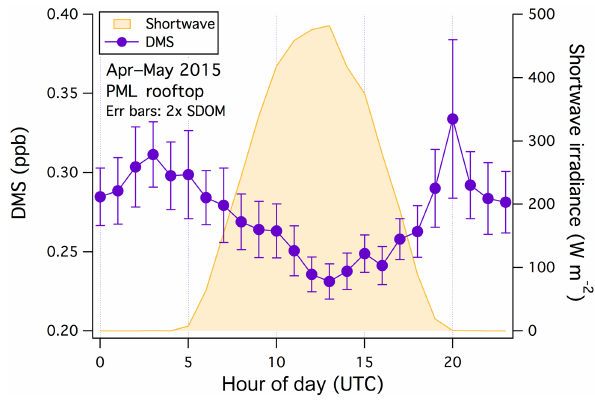
Figure 6. Average diel variability in DMS mixing ratio and short- wave irradiance, measured from the PML rooftop between April and May 2015 (wind from the marine sector). Error bars indicate 2 standard